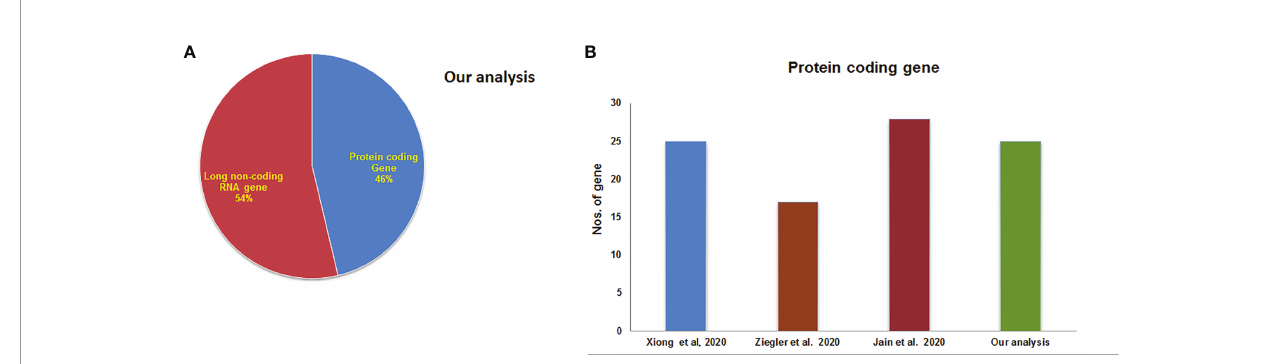
FIGURE 5 | Signi fi cantly expressed genes from our experiments and other experiments. (A) The percentage of signi fi cantly expressed protein-coding genes and lncRNAs. (B) Total no. of top-ranking protein-coding genes from our study and other